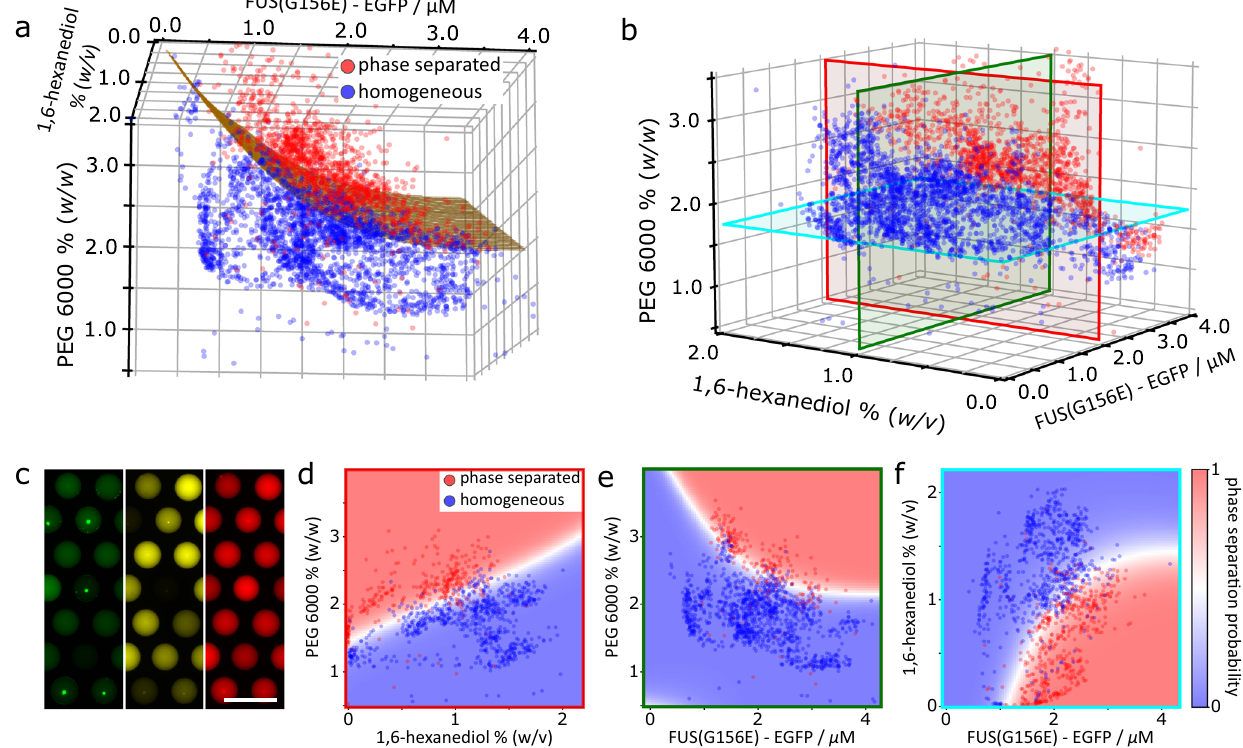
Fig. 4 | Generation of multidimensional phase diagrams using the PhaseScan platform. a , b 3D phase diagram of EGFP-tagged FUS G156E vs. PEG 6000 vs. 1,6-HD concentration. N =3904droplets. c Epi fl uorescencemicroscopyimagesoftrapped microdroplets with EGFP (green), Alexa546 (yellow), and Alexa647 (red) fl uores- cencecorresponding to FUS G156E and 1,6-HD, and PEGconcentrations, respectively. d – f 2D slices of the 3D phase diagram, with outline colours corresponding to the